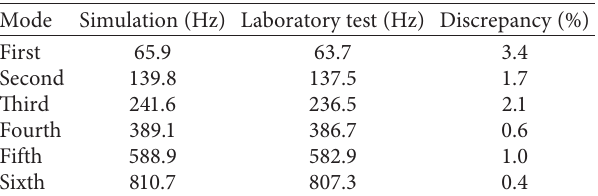
Table 4: Comparison of experimental and simulated vertical modal